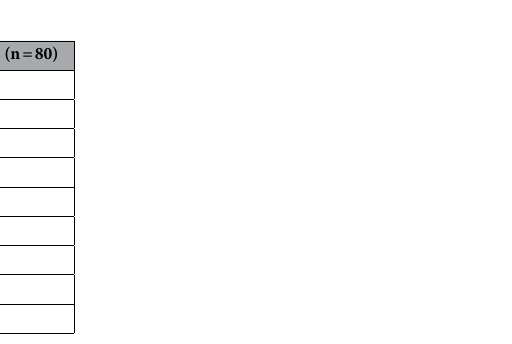
Figure 1. Participant flow in the present study.